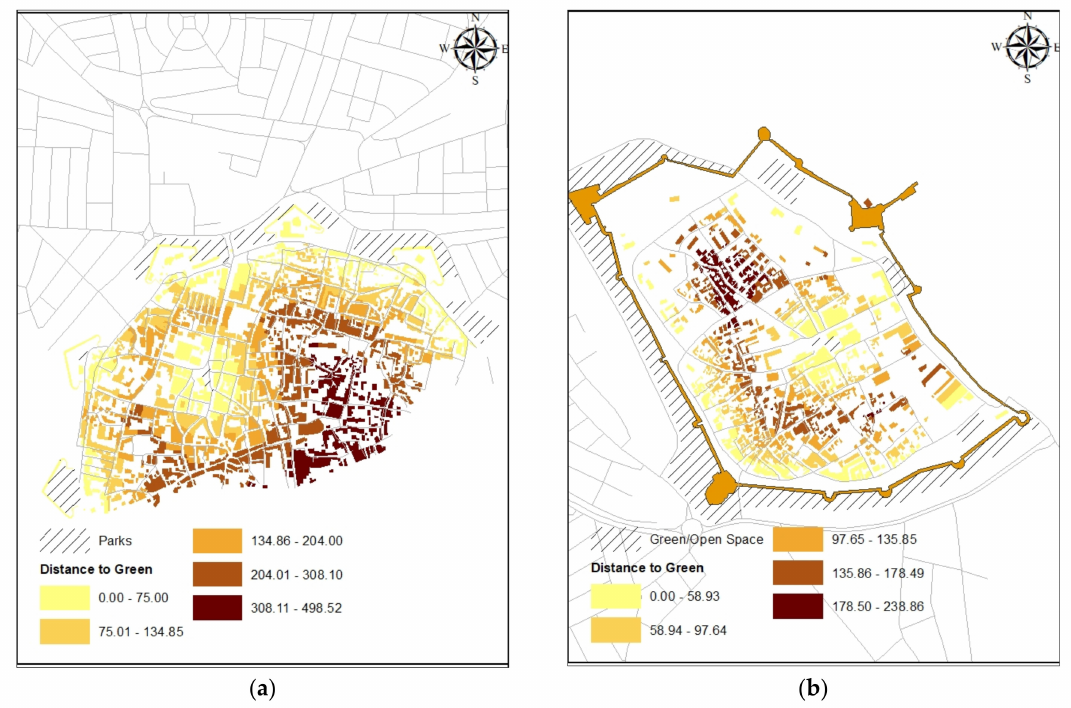
Figure 7. Accessibility to Green Space in Nicosia ( a ) and Famagusta ( b ) Walled Cities. Percentage of Shared Streets or Pedestrianized Streets (T2): The impact of pedestrian movement on the quality of life in cities is well documented in the literature (see